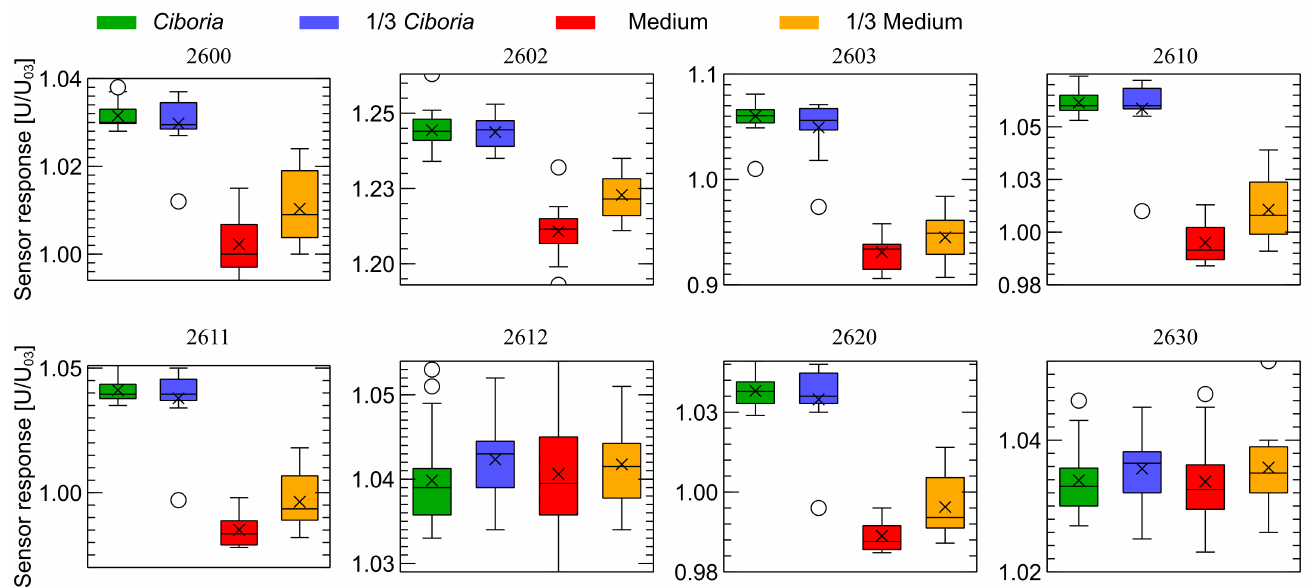
Figure A3. Distribution of the sensor response magnitude collected at the moment of 100 sensor reads from the beginning of the third observation stage (Figure A1). Comparison of four categories of samples used in the experiments.